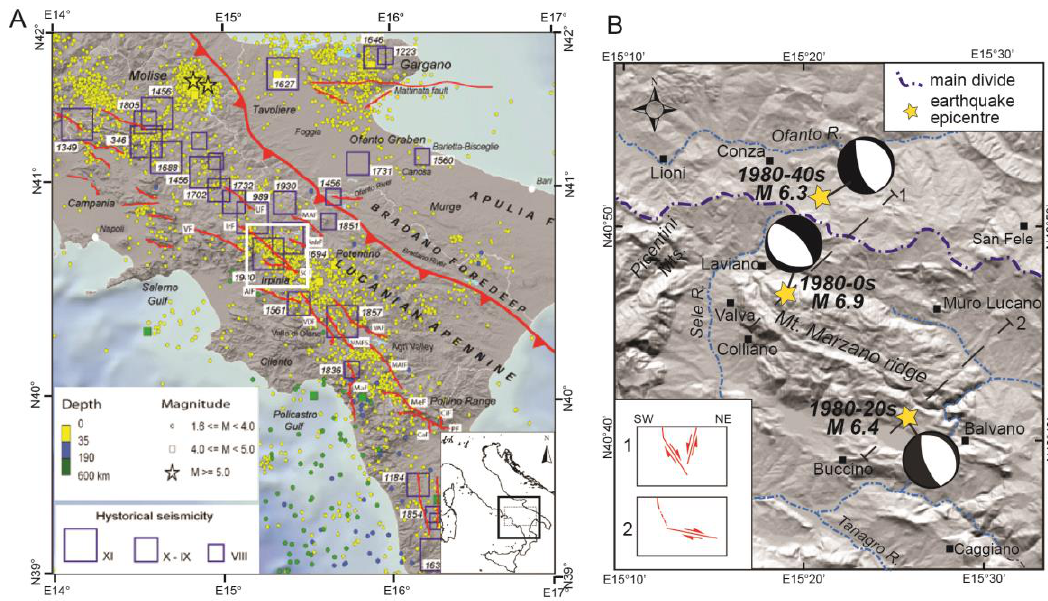
Figure 1. ( A ): Historical and instrumental seismicity of southern Italy (modified after Frepoli et al. [2]). The white frame indicates the location of the map in diagram B. ( B ): Epicentral locations for the three main rupture episodes at 0 s, 20 s, and 40 s, with Mw 6.9, 6.4, and 6.3, of the 1980 Irpinia earthquake; focal mechanisms from Westaway and Jackson [3]. Inset in the lower left corner are schematic sections (location in the map), indicating the fault system activated with the 1980 earthquake (redrawn from Barnard and Zollo [1]).